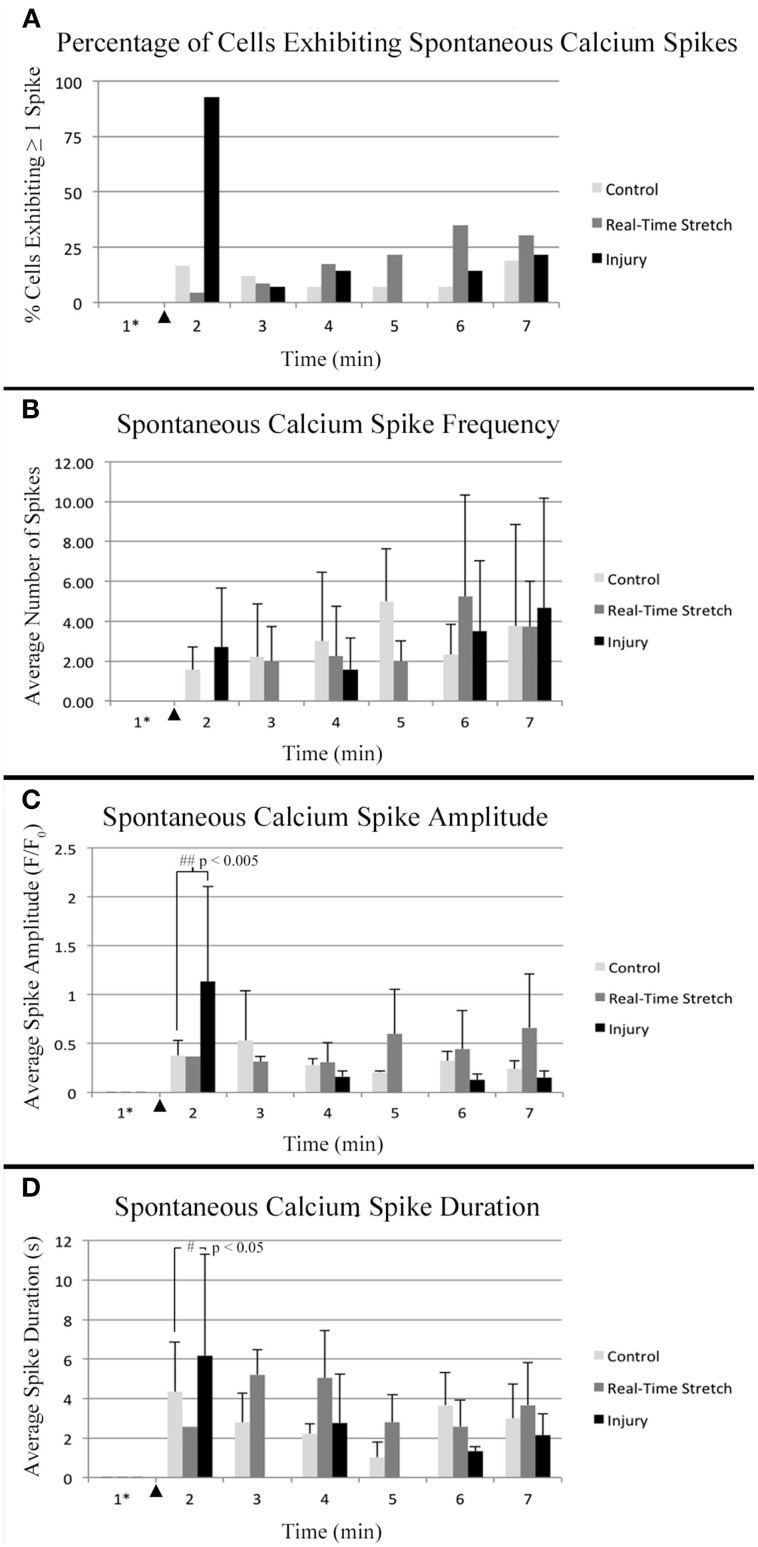
Intracellular calcium flux. Quantified data from control neurons (n = 42, 8 DIV), real-time stretched cells (n = 11, 11 DIV), and stretch-injured cells (n = 14, 11 DIV) was averaged over 1-min periods for analysis of trends associated with experimental perturbation. (A) The prevalence of spiking increased ubiquitously in injured cells at the time of injury. (B) The frequency of spikes, in spiking cells, tended to increase in all cells over time. (C) The amplitude of calcium spikes was significantly larger in injured cells at the time of injury than during subsequent spikes. (D) The duration of calcium spikes at the time of injury was significantly longer at the time of injury than in subsequent spikes. Graphs show mean ± standard deviation. ▴ Time of injury in injured cells/start of real-time stretch in stretch-grown cells. *Cells that spiked during the first minute of recordings were excluded from analysis.